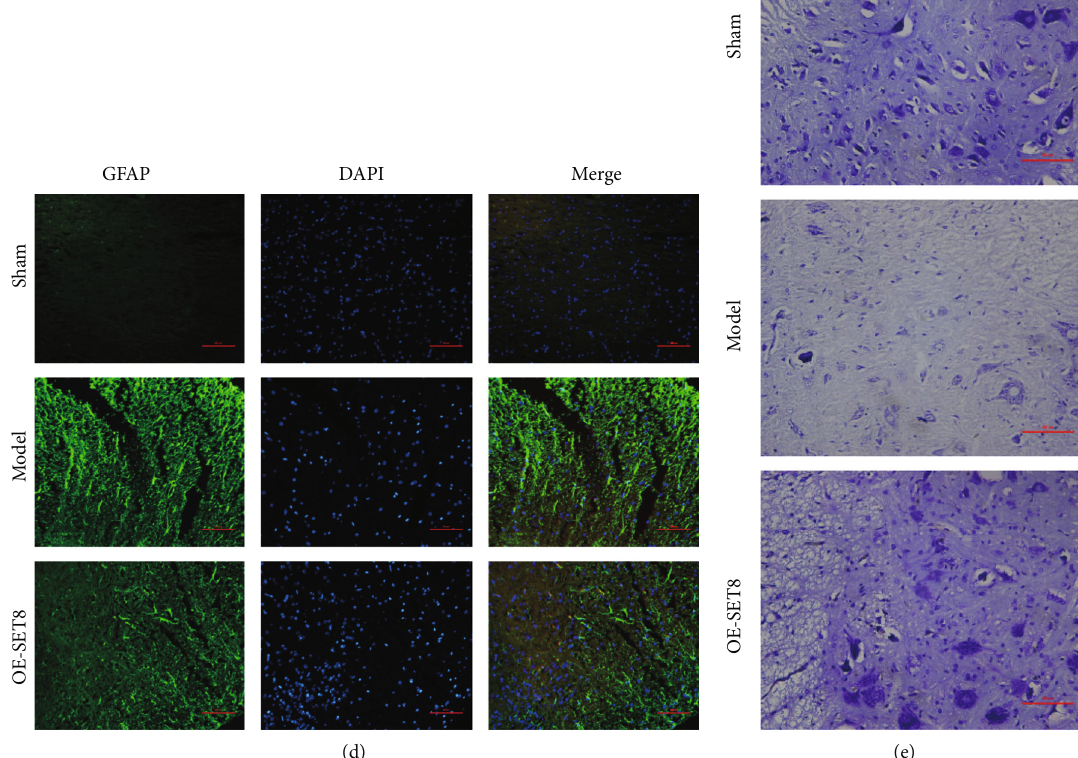
Figure 5: SET8 promotes motor function recovery after SCI in vivo in rats. (a) Analysis of SET8 and Keap1 expression in the sham, model, and OE-SET8 groups by immunohistochemistry; Western blotting of the astrocyte autophagy-related proteins LC3II/I, P62, and Beclin1 in (b), the glial scar formation-related proteins brevican and neurocan in the sham, model, and OE-SET8 groups in (c), and OE-SET8 expression in the di ff erent groups. (d) Immuno fl uorescence analysis of astrocyte morphology and glial scar formation in the sham, model, and OE-SET8 groups. The number of surviving neurons in the sham, model, and OE-SET8 groups was detected by Nissl staining. (e) The number of surviving neurons was detected by Nissl staining in the sham, model, and OE-SET8